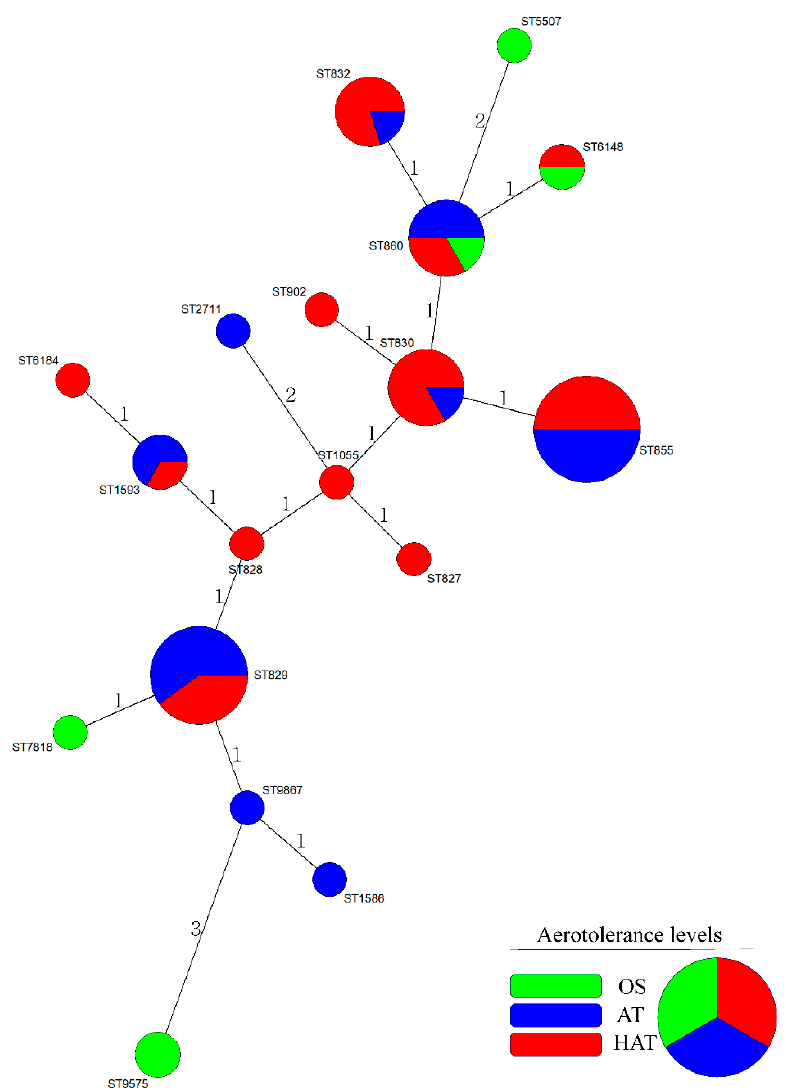
Figure 1. Minimum spanning tree (MST)-based cluster analysis of C. coli isolates according to aerotolerance levels. Cluster analysis of C. coli isolates from duck sources is based on multi-locus sequence typing (MLST) sequence types (STs). The analysis was performed using an MST with hypothetical nodes based on allelic numbers of seven MLST housekeeping genes. Each circle represents the MLST ST and the diameter of each circle represents strain numbers for each ST. Colors indicate aerotolerance levels of C. coli in each MLST ST (green, OS; blue, AT; red, HAT). OS, oxygen-sensitive; AT, aerotolerant; HAT, hyper-aerotolerant.